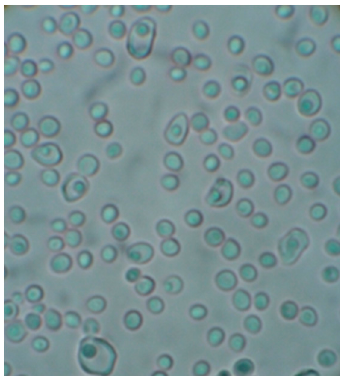
Figure 9. Light microscopy of Candida vinaria from a dual culture with L. muscarium . Most yeast cells appeared damaged and/or bigger than usual (Fenice et al. , unpublished results).